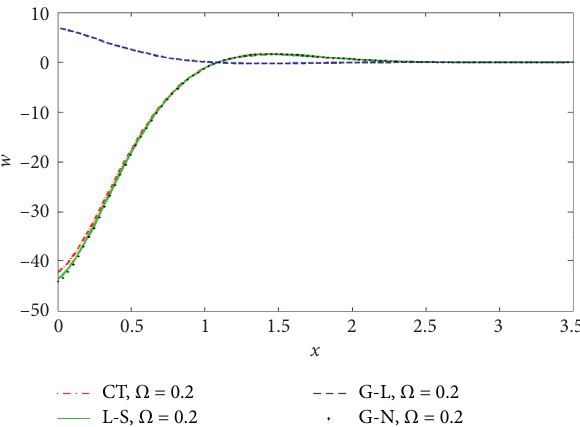
Figure 3: Vertical displacement w concerning x under four thermoelastic theories.